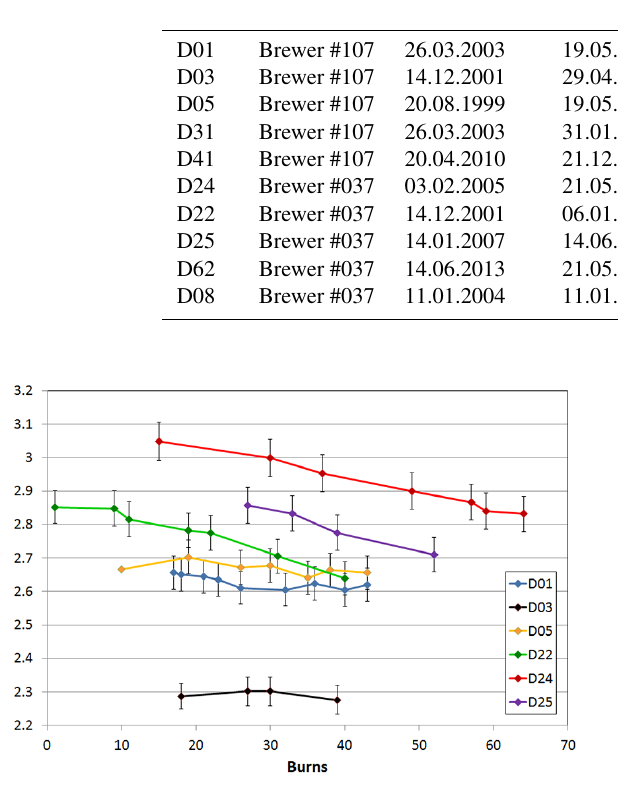
Table 1. Information on the primary standard lamps used in calibration of Brewer #037 and #107. Lamp Primary to 1st calibration Last calibration Number of Scans at home (re)calibrations laboratory